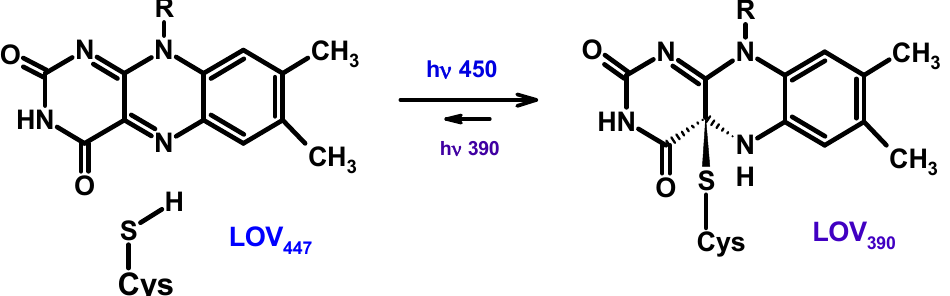
Figure 21. Т he blue light-induced formation of a covalent adduct for LOV domains that thermally reverts to the parental state or can partially be photoreverted with UVA/violet light [225]. It is assumed that the excited flavin passes into the triplet state, which leads to the formation of the FMNH · -H 2 CS · radical pair. FMNH · and H 2 CS · rapidly interact with each other and form an adduct. Since a covalent bond is formed, the time it takes for the reverse process to occur (from several seconds to several hours) depends on various factors: temperature, amino acids of the active center, etc. UVA/blue light can also accelerate this process